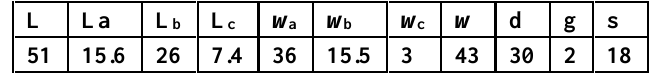
Figure 2: Modeled and simulated reflection coefficient of the proposed RFID tag antenna with and without the triangular stubs.